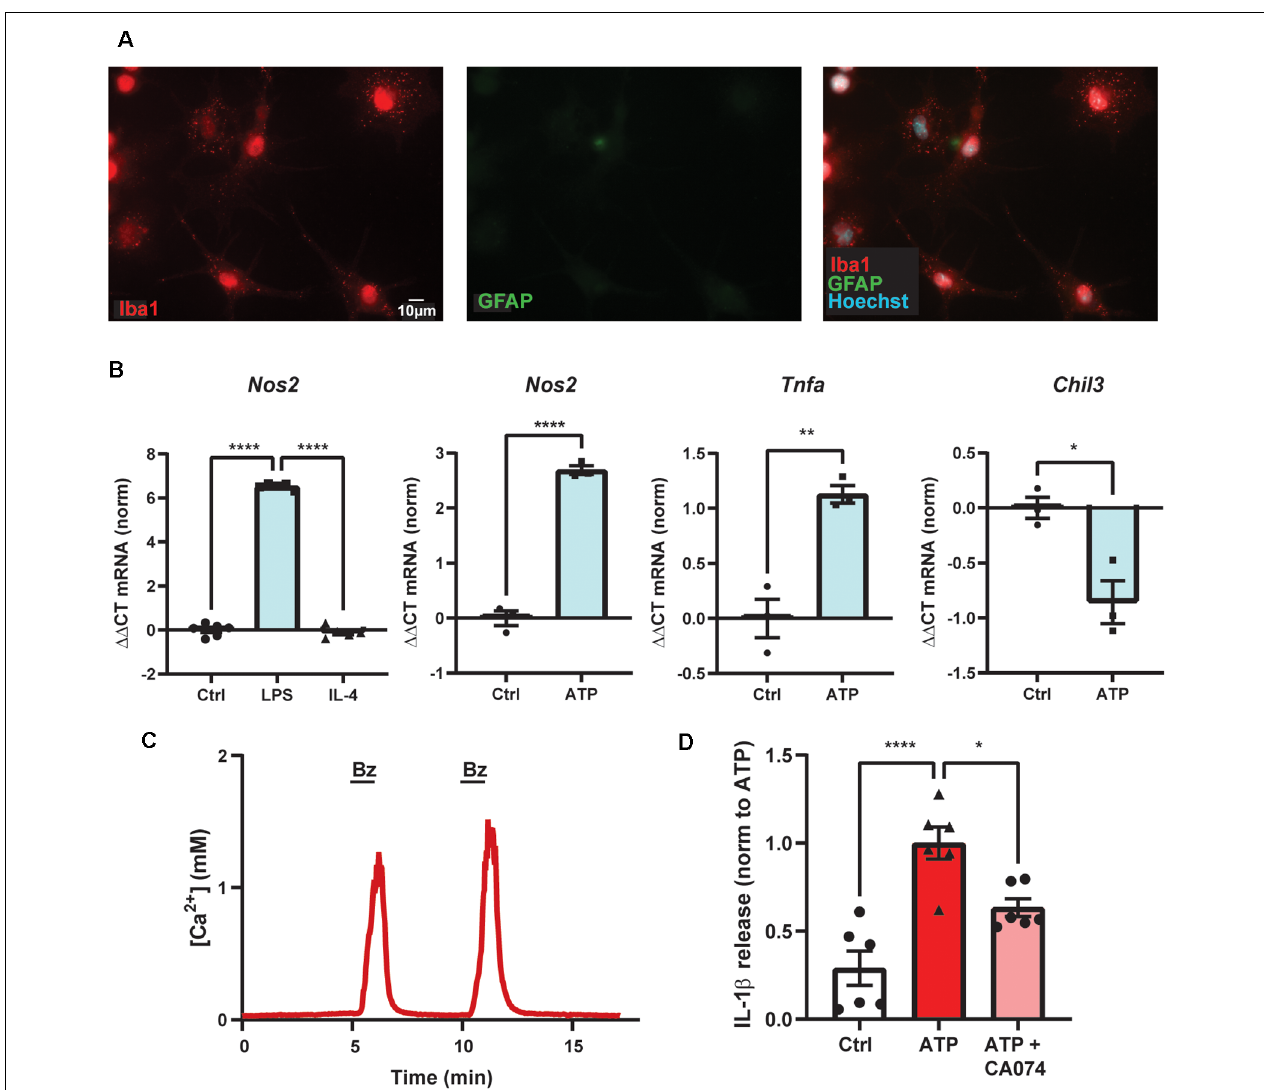
FIGURE 3 | ATP-dependent IL-1 β release from primary microglial cells involves cathepsin B. (A) Purity of primary mouse brain microglia cultures shown with high staining for marker Iba1 (red) and low staining for astrocytic marker GFAP (green). (B) Primary microglial cultures increased expression of Nos2 with 4 h exposure of LPS but not IL-4, as expected for microglial cells polarized into the M1-state (**** p < 0.001). Exposure to 1 mM ATP for 4 h increased expression of Nos2 (**** p < 0.001) and Tnfa (** p = 0.0042) and decreased expression of Chil3 (* p = 0.014) as compared to control (Ctrl) using quantitative PCR. (C) Evidence of functional P2X 7 receptors in primary murine microglial cells indicated by the robust, reversible and repeatable elevation of cytoplasmic calcium when briefly exposed to 100 µ M BzATP (line); cells were loaded with Ca 2+ indicator fura-2. (D) Release of cytokine IL-1 β triggered by exposure to 1 mM ATP for 1 h was reduced